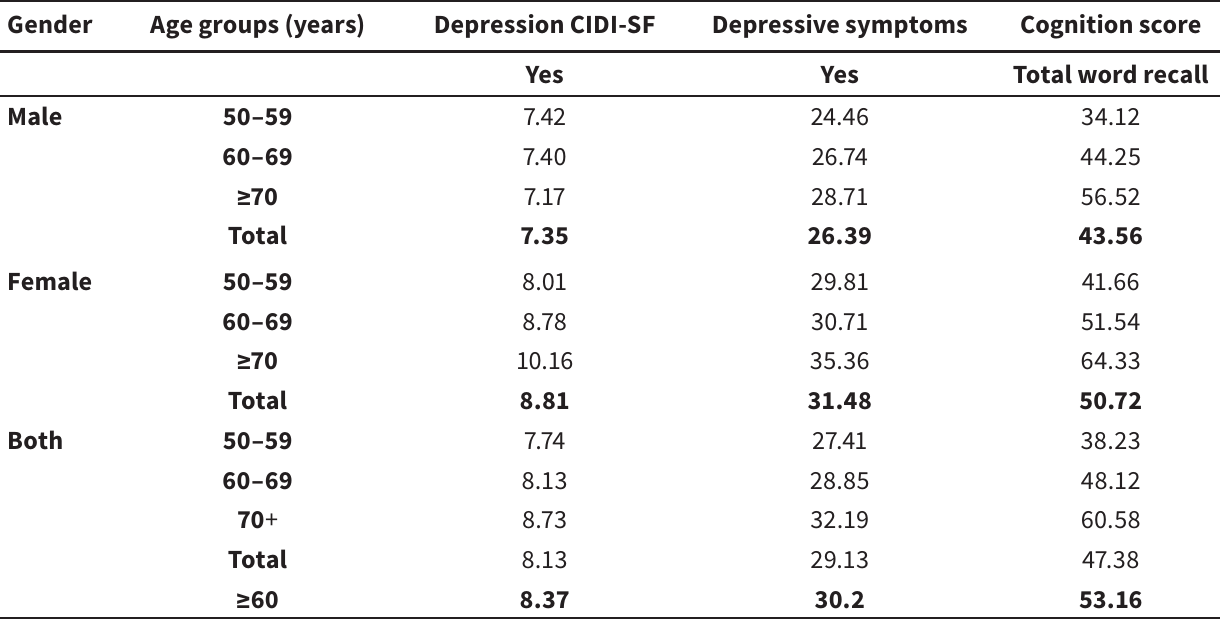
Mental health conditions of the aging population in India